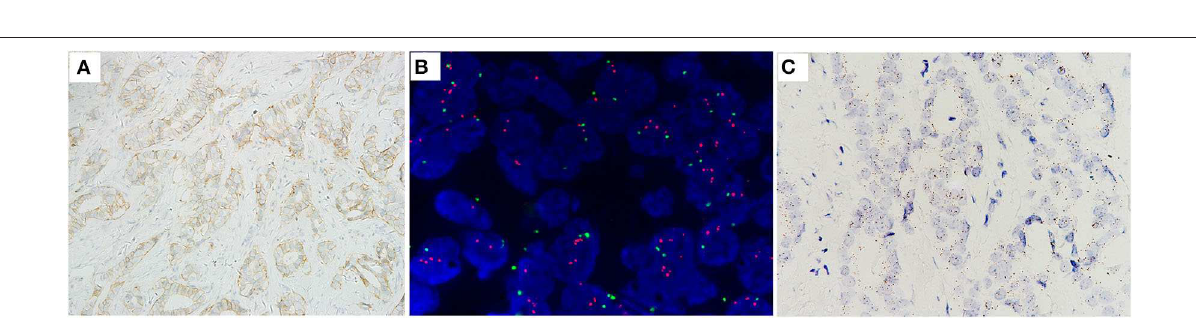
the study group. Case no. 30, with the highest HER2/CEP17 ratio of 3.90, exhibited a score of 1 by RNAscope. Case no. 31, with the highest level of mRNA expression (score 4 by RNAscope), had cluster HER2 transcript signal features showing a HER2/CEP17 ratio of 2.06 and 40% of Ki 67 index. However, case no. 17 and 36, with the same levels of HER2 RNA expression (score 3 by